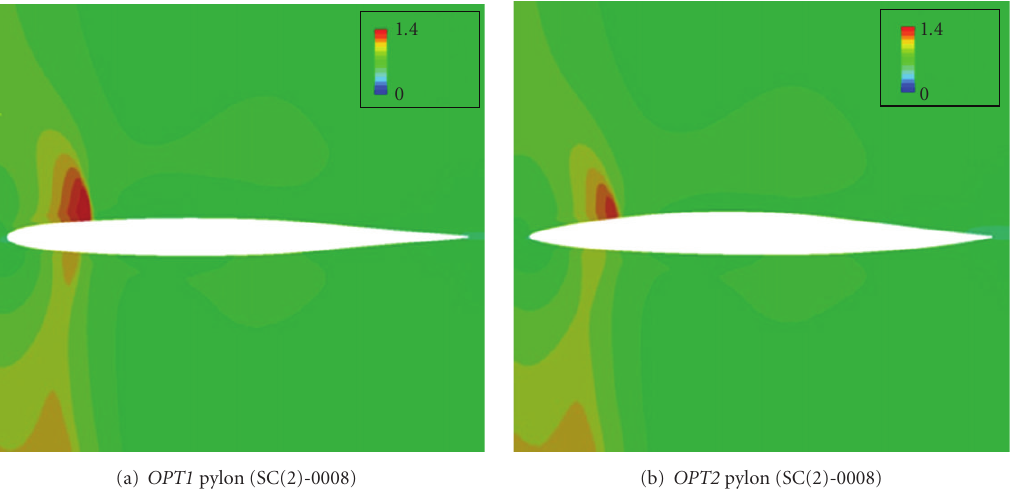
Figure 18: Comparison of Mach contours.